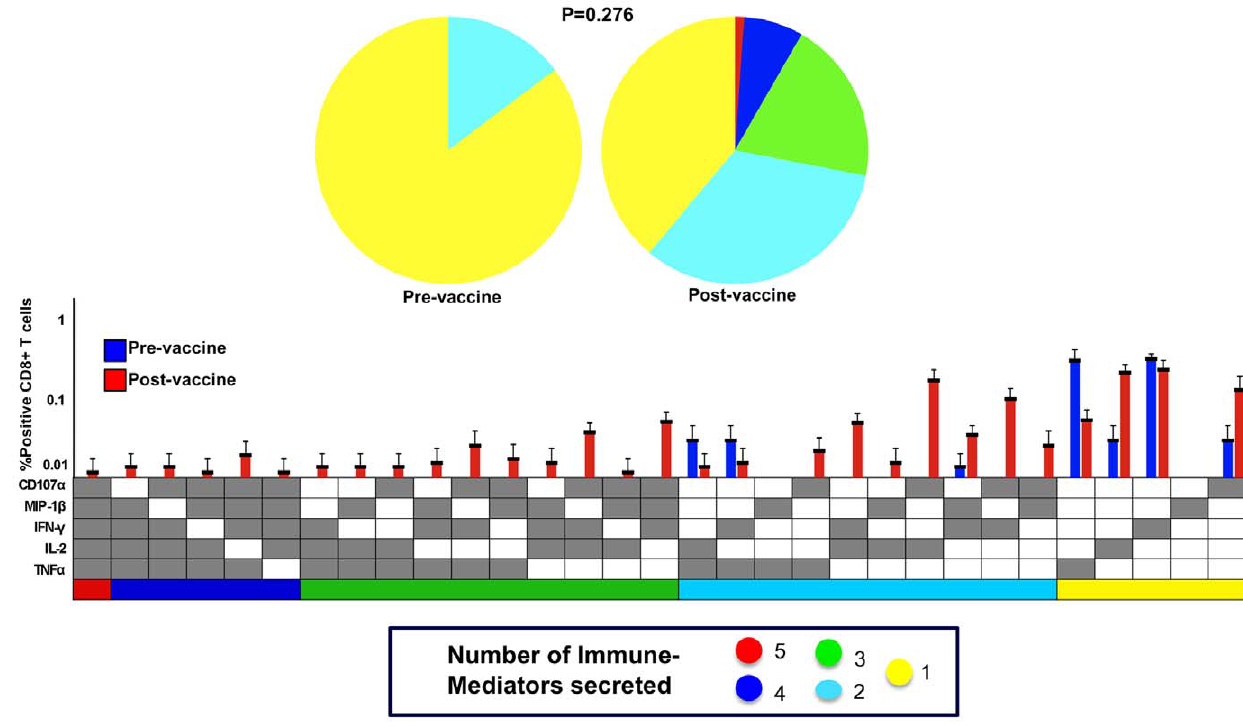
Figure 5. Polyfunctional response of CD8 + T cells pre- and post-vaccine after Treg depletion. The response patterns are color-coded by the number of positive functions. The x-axis contains the combinations of positive immune mediators whereas the y-axis is the percentage of CD8 + T cells secreting each combination. The pie charts show the proportion of CD8 + T cells that are polyfunctional, i.e., secreting more than 1 immune mediator in response to stimulation with Gag peptide. There was increased polyfunctionality after the Treg were removed. Despite the apparent increase in polyfunctionality, the permutation comparison test showed no statistical difference between the two pie charts. (P=0.276; N=7)